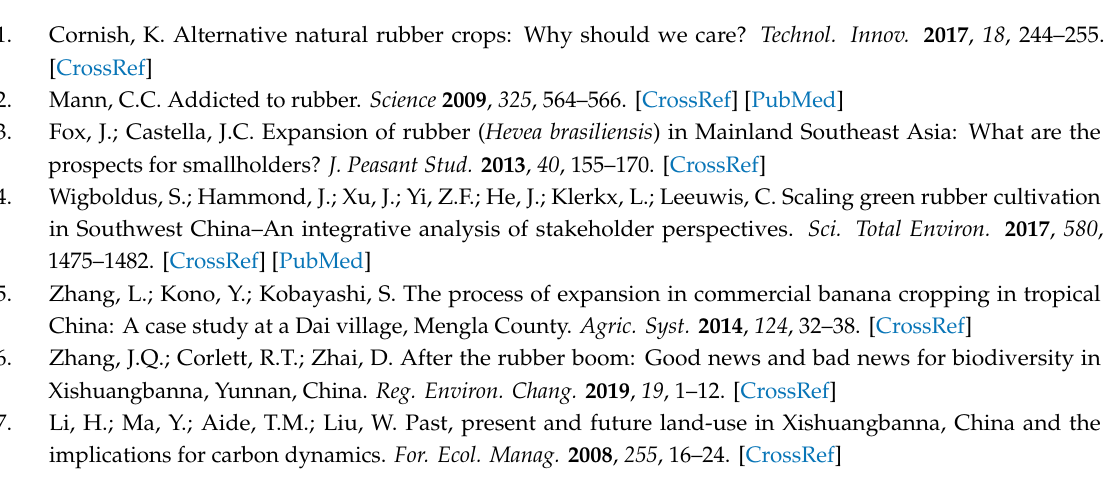
Figure S1: Schematic diagrams of (a) the rubber monoculture and (b) the rubber tree and sharp-leaf galangal agroforestry system (RS-AFS). Figure S2: Randomly selected blocks for sampling. Figure S3: (a) Information on the phenophases of rubber trees and (b) the monthly precipitation and monthly mean temperature during the study period (data were provided from the Xishuangbanna Station for Tropical Rainforest Ecosystem Studies). FS, fruit setting; FR, fruit ripening; DS, dormant stage; LS, leaf shedding; LF, leaf flushing; LE, leaf expansion; and FP, flowering